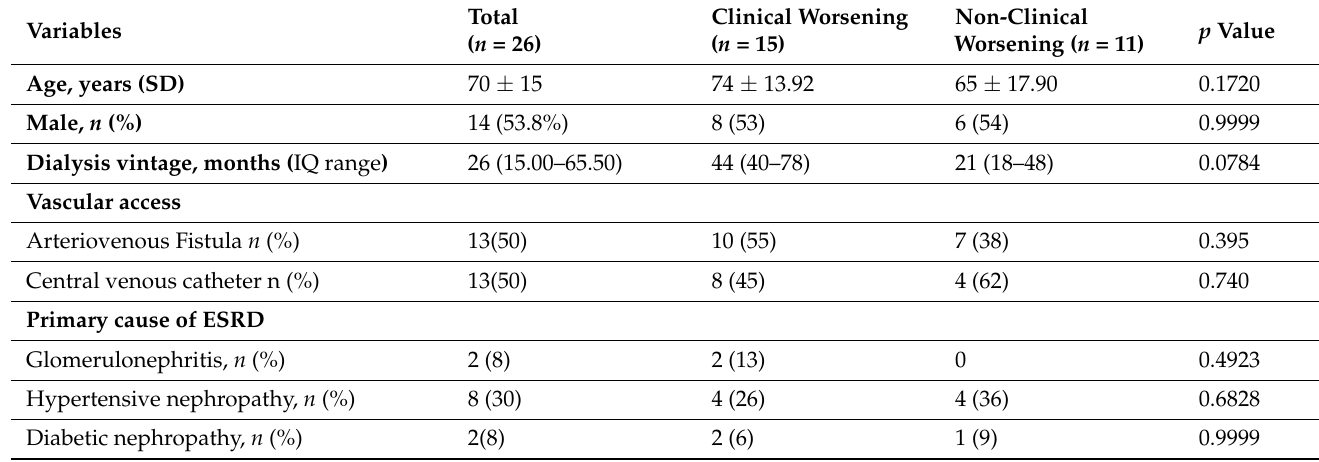
Table 1. Baseline characteristics of CHD patients affected by SARS-CoV-2